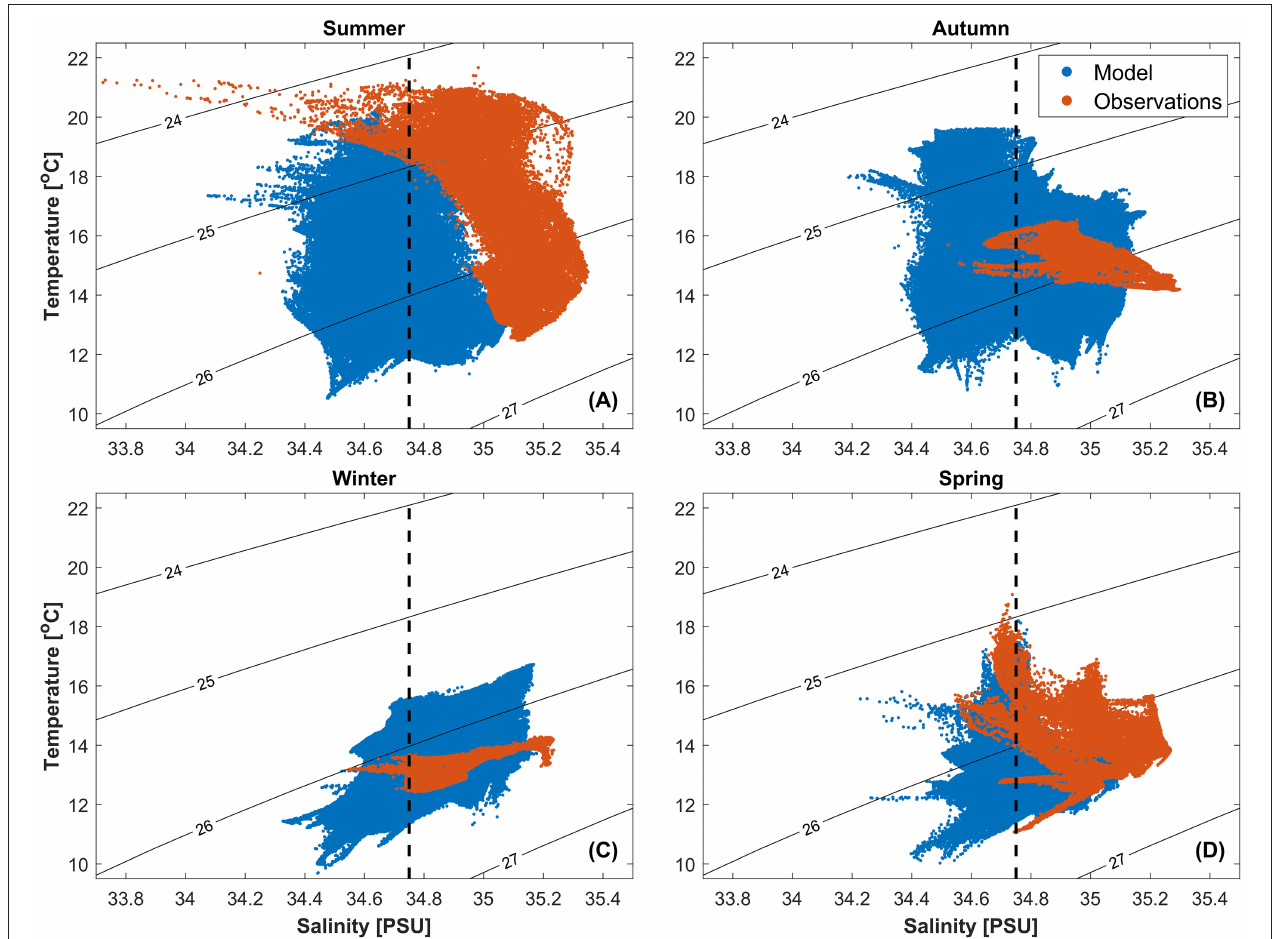
FIGURE 2 | T-S diagram for (A) Summer, (B) Autumn, (C) Winter and (D) Spring overlaid on isopycnals for modelled results (extracted along an averaged glider track in the modelled domain) and glider observations concatenated according to their seasonal affiliation. Salinity threshold value of 34.75 psu used to detect observed LSMFs overlayed (black dashed